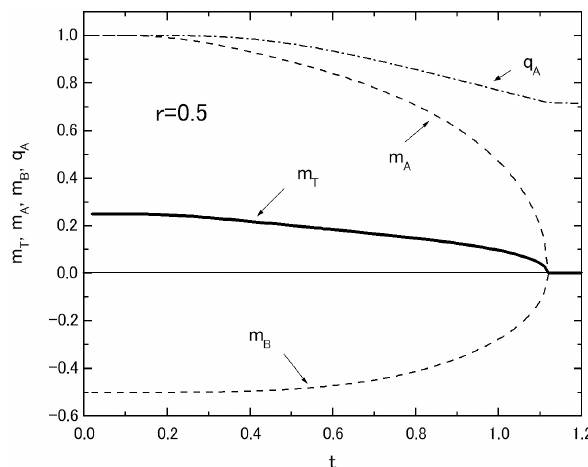
Figure 3. The temperature dependences of m T (solid curve), m A (dashed curve), m B (dotted curve) and q A (dot-dashed curve) in the system A with a fixed value of r = 0 . 5, when the value of h is given by h = 0 . 0 .